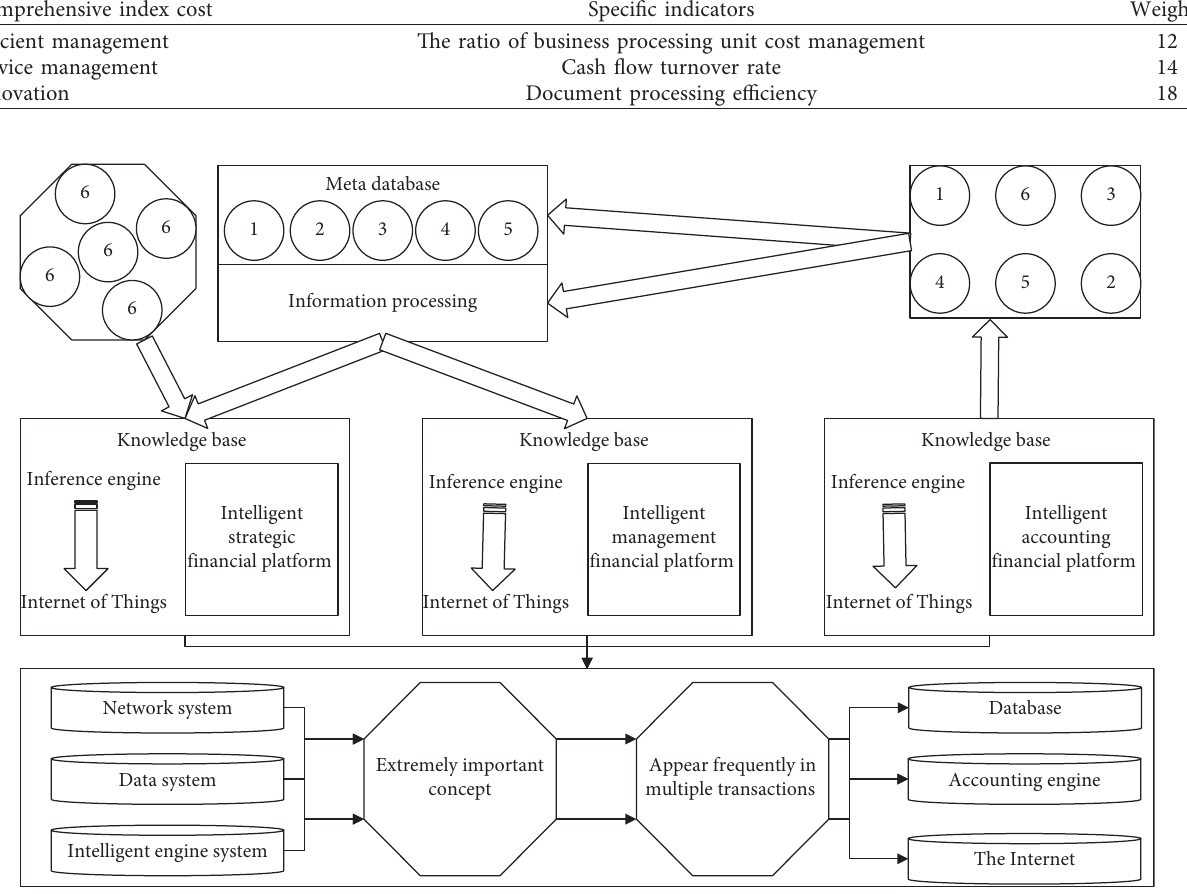
Figure 3: Smart financial system decision